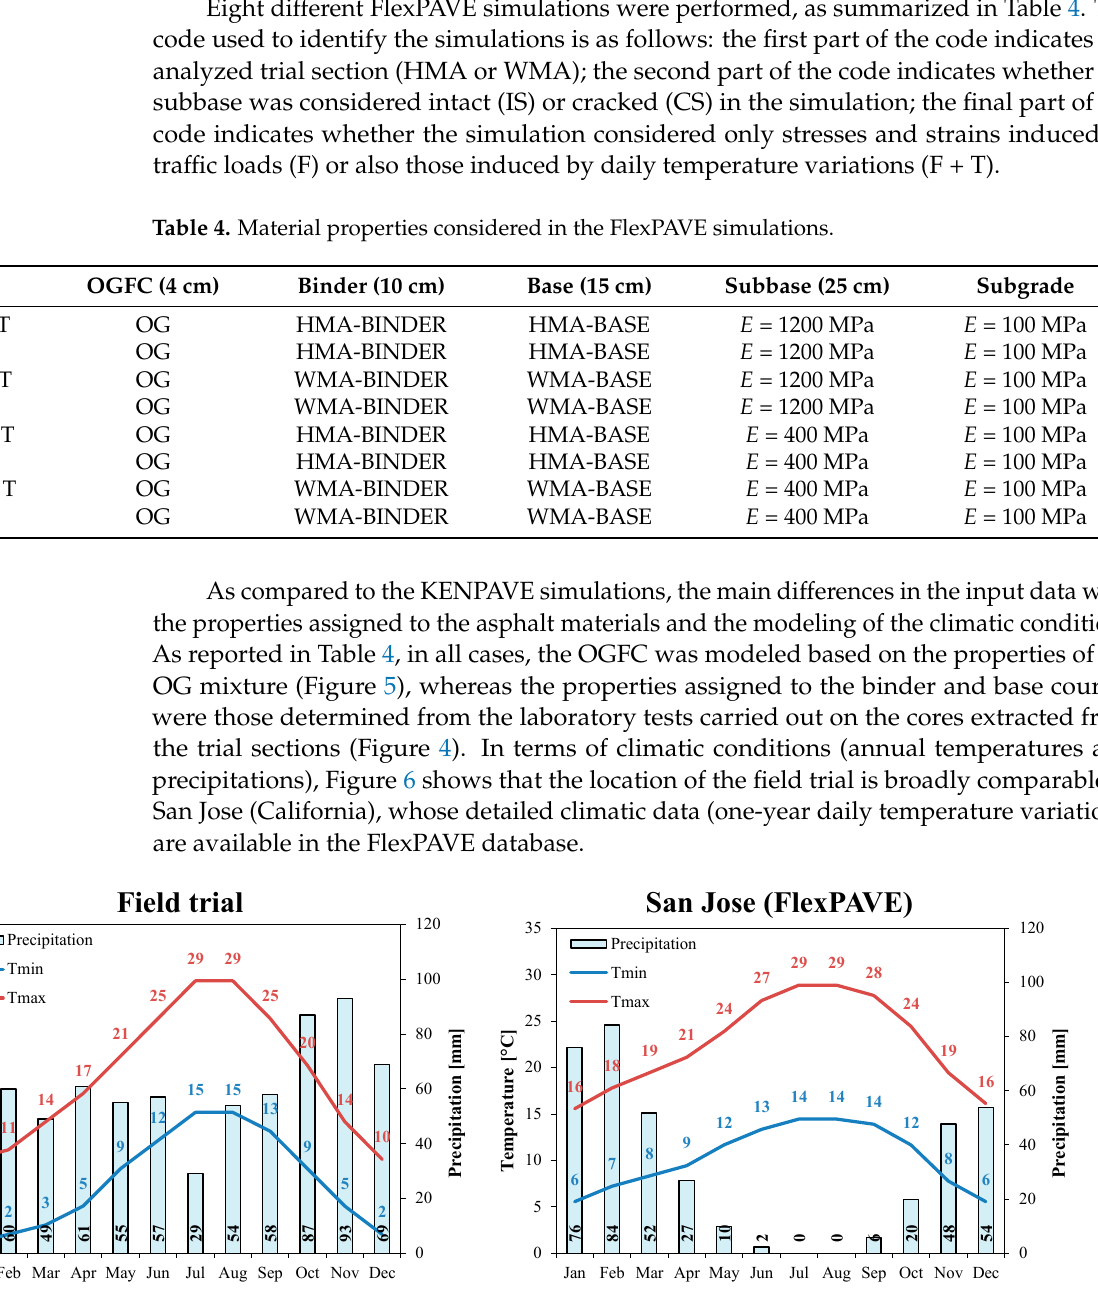
Figure 6. Comparison of the climatic conditions for the location of the field trial and San Jose (data available in FlexPAVE).